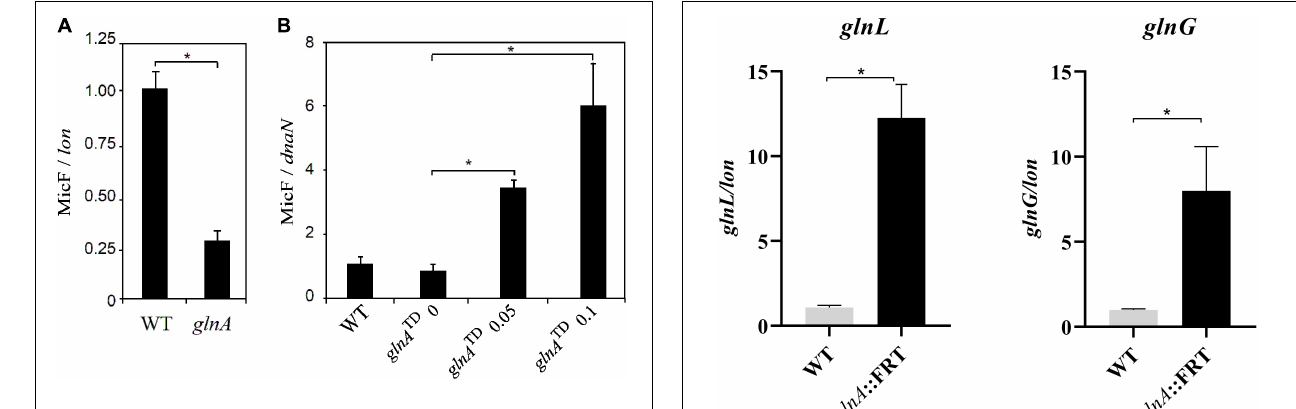
FIGURE 4 | Expression of MicF transcripts depends on expression of glnA ::FRT. Expression of MicF was studied in a glnA null mutant and in the glnA TD mutant with different concentrations of chlortetracycline (0, 0.05, or 0.1 µ g/mL). Expression of MicF was normalized to the expression of lon (A) or dnaN (B) and compared to the expression of MicF in the WT strain. Results are average of at least three biological replicates. Asterisks indicate significance, calculated by Student’s t -test, of results linked by brackets. * p ≤ 0.05.